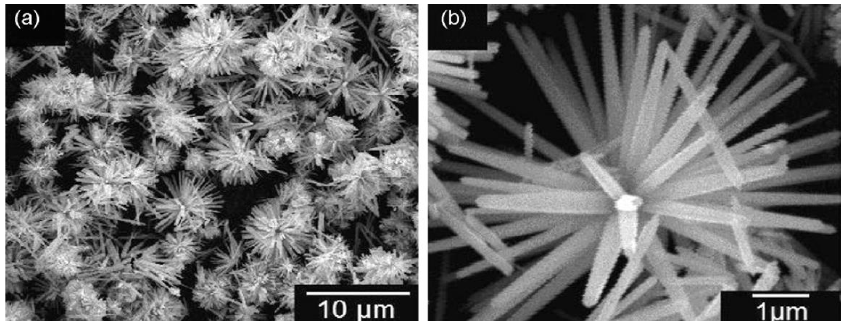
Figure 10. ( a ) SEM and ( b ) TEM images of ZnO nanoparticles. Reproduced from [90] under the terms of the Creative Commons Attribution 2.0 International license.